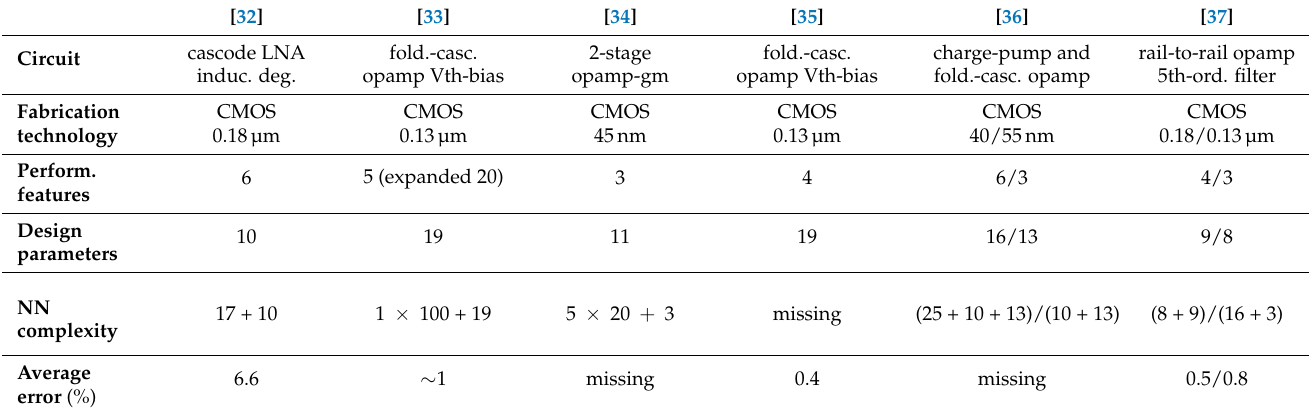
Table 6. Comparative summary of hybrid techniques in the prior